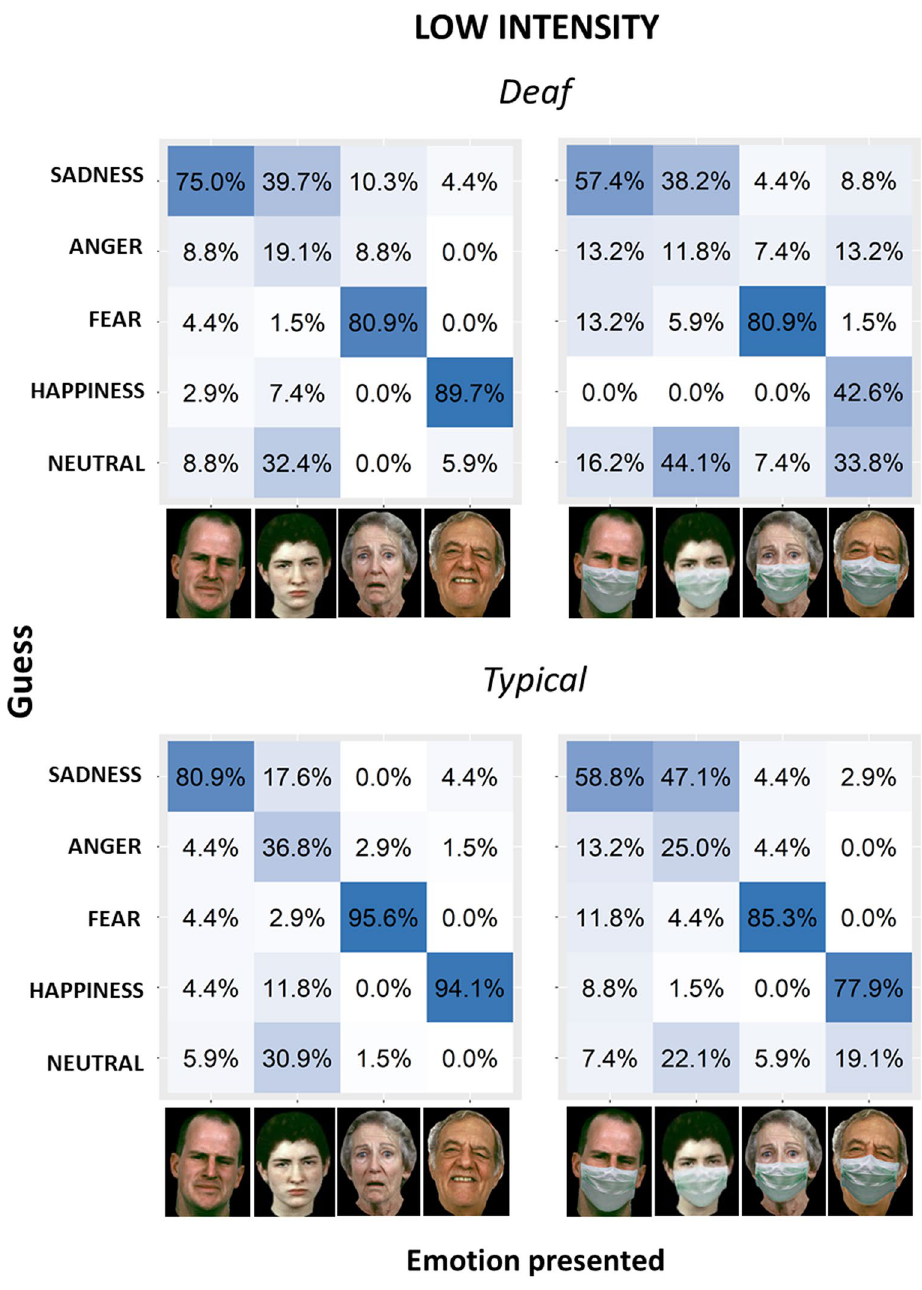
Figure 4. Confusion matrices for emotion inference from low-intensity facial configurations without (left) and with (right) face masks for deaf (top) and hearing (bottom) groups. The x-axis shows the presented stimuli. The y-axis shows the emotions perceived by participants. Columns report the percentage of responses for each emotion. Face images were obtained with permission from the ER-40 colour emotional stimuli public database 29,30